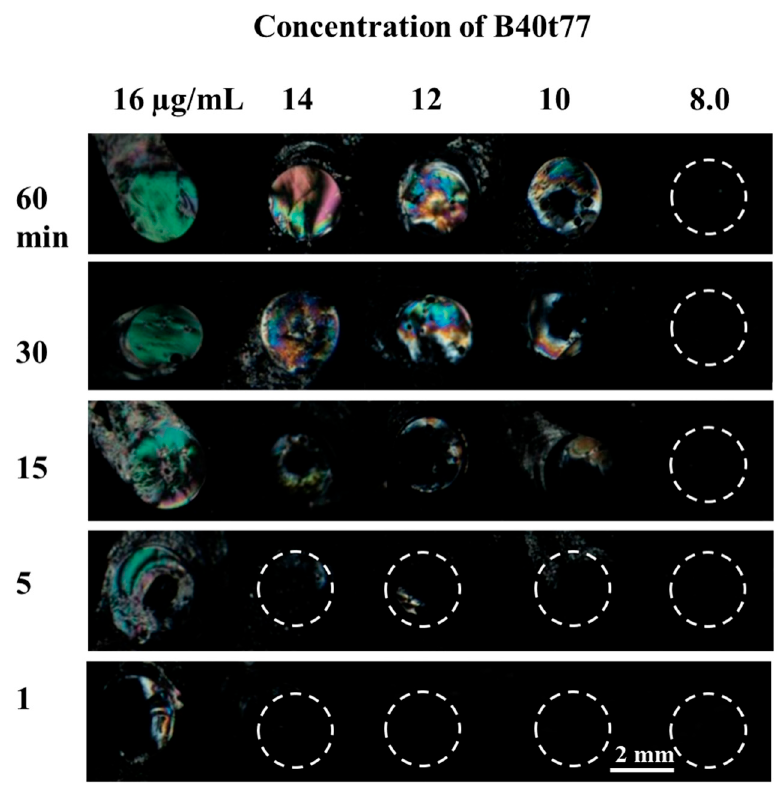
Figure 4. Optical images of LCs supported on a DMOAP-coated slide immobilized with B40t77 aptamer solution of different concentrations showing effects of different immobilization times; the B40t77 aptamer concentrations used are 16, 14, 12, 10 and 8 µg/mL.